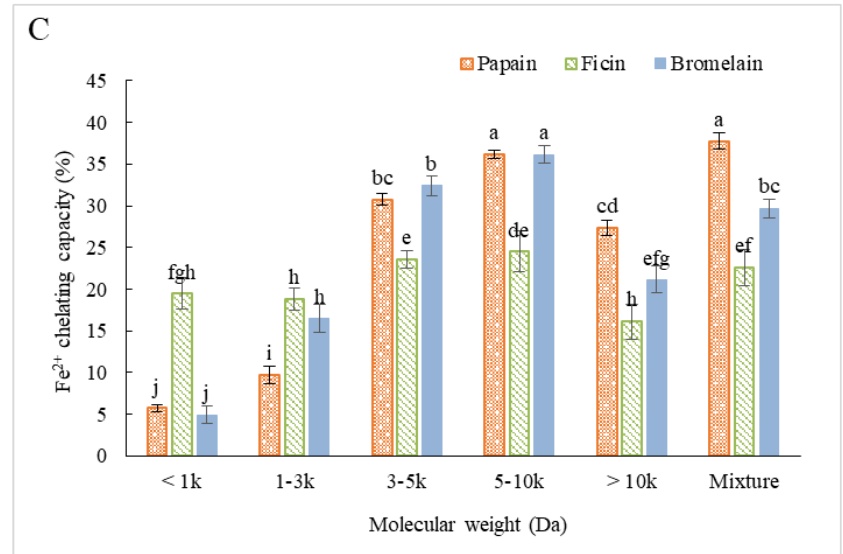
Figure 7. Antioxidant activities of different peptide fractions ultrafiltrated from CGM hydrolysates prepared by papain (3 h), ficin (4 h), and bromelain (4 h). ( A ) DPPH radical scavenging activity at 5 mg/mL; ( B ) ABTS radical scavenging activity at 1 mg/mL; and ( C ) Fe 2+ chelating activity at 1 mg/mL. (Different letters indicate significant differences at p < 0.05 for each enzyme).